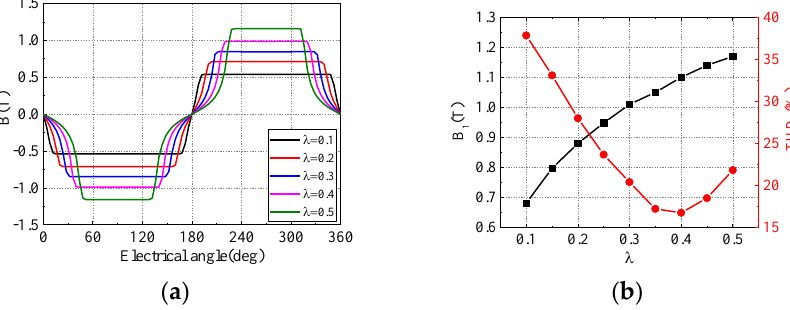
fundamental amplitudes and THDs are shown in Figures 5 and 6 when k is changing.